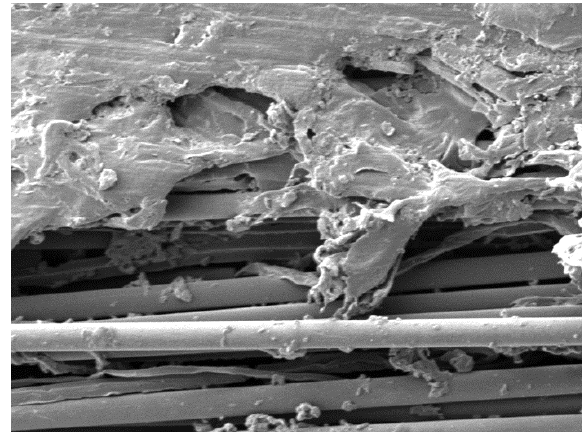
Figure 17. Micrograph of pretensioned fiber composite.